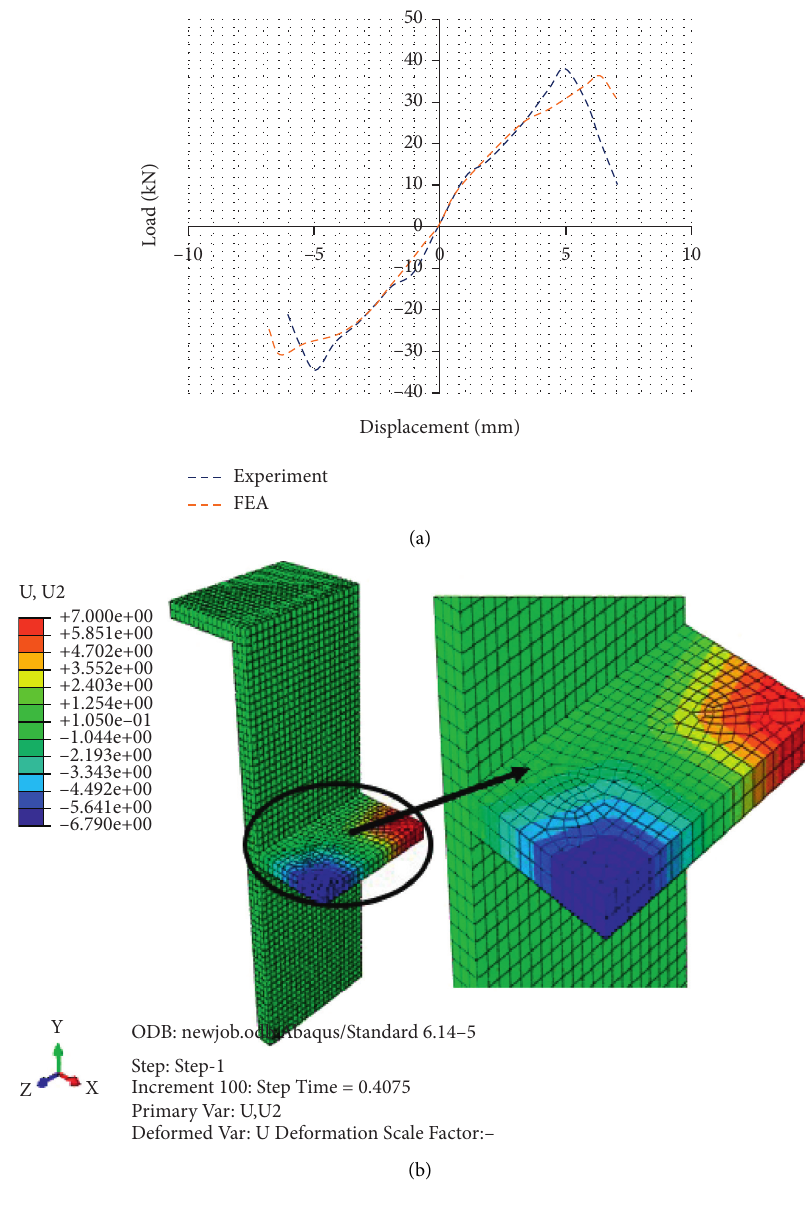
Figure 8: Comparison of experimental [13] and finite element results. Table 4: Comparison of FE analysis and experimental